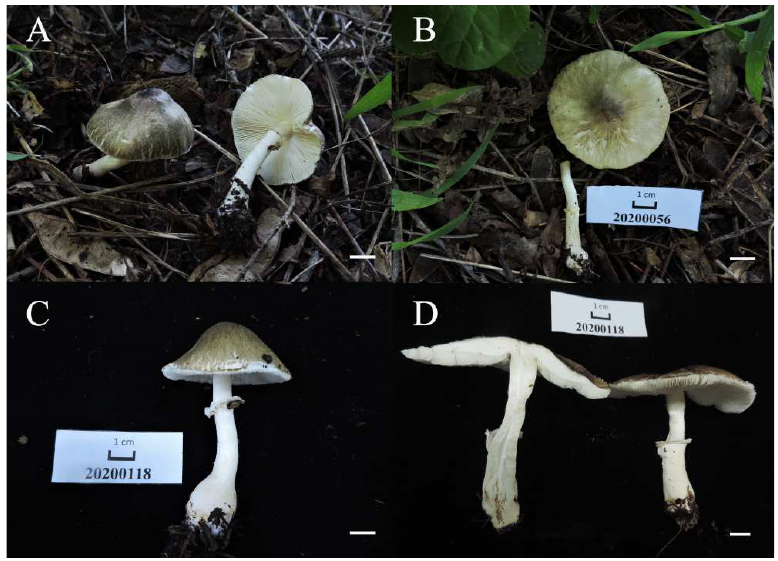
Figure 4. Basidiomata of Leucoagaricus atroviridis . ( A , B ) SYAU FUNGI 073; ( C , D ) SYAU FUNGI 074. Scale bars: 1 cm.